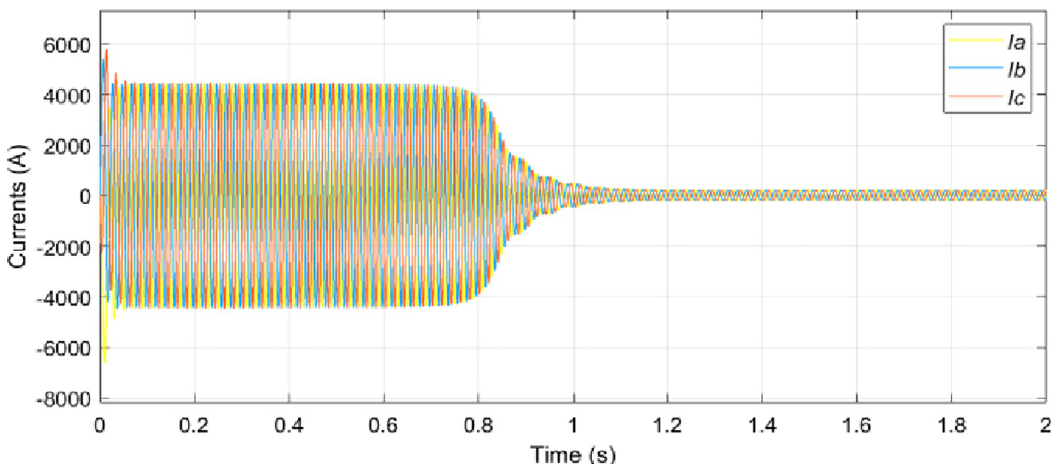
Fig 4. Stator phase